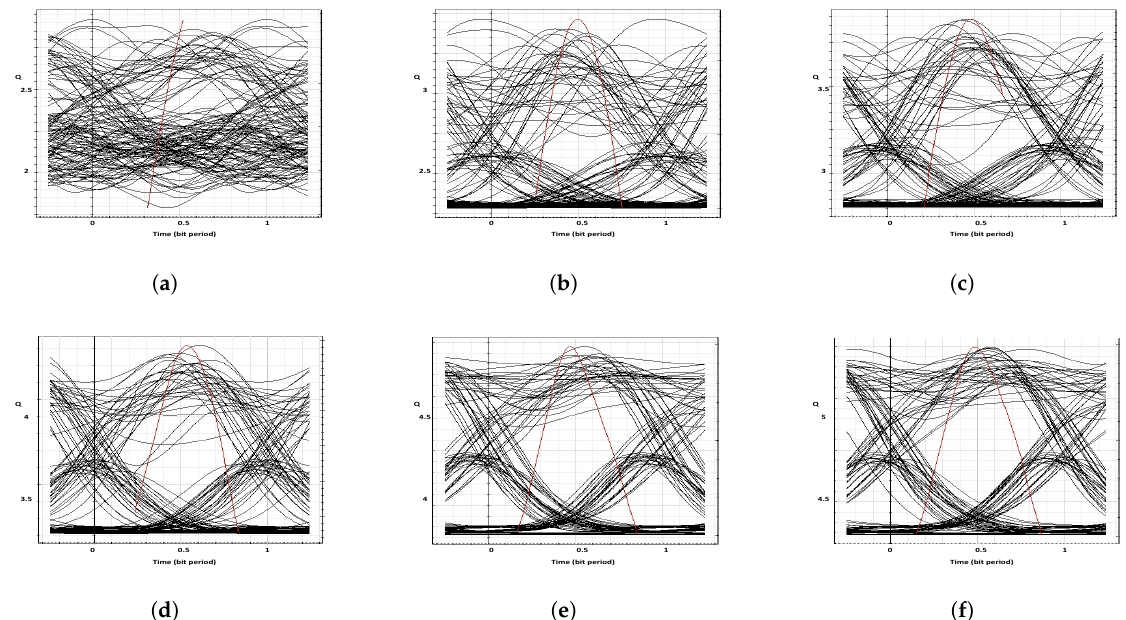
Figure 16. Results for Eye-diagrams; ( a – c ): For 12.5 GHz, 25 GHz, 50 GHz channel spacings, respectively, without RIrNLs compensation, ( d – f ): For 12.5 GHz, 25 GHz, 50 GHz channel spacings, respectively, after RIrNLs